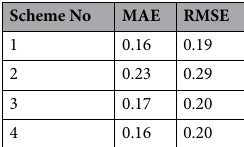
Table 5. Measurement indicator (MAE and RMSE).